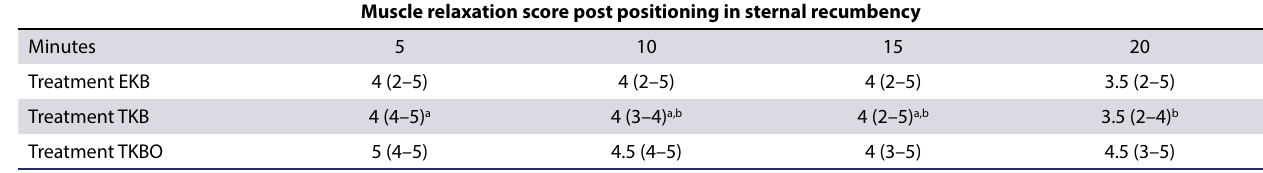
Table III: Muscle relaxation scores and significance between timepoints within a treatment group in black-faced impala ( Aepyceros melampus ssp. petersi ) administered 2.0 mg etorphine, 50 mg ketamine, and 10 mg butorphanol, (treatment EKB) or 2.0 mg thiafentanil, 50 mg ketamine, and 10 mg butorphanol (treatment TKB) or 2.0 mg thiafentanil, 50 mg ketamine, and 10 mg butorphanol with supplemental oxygen (treatment